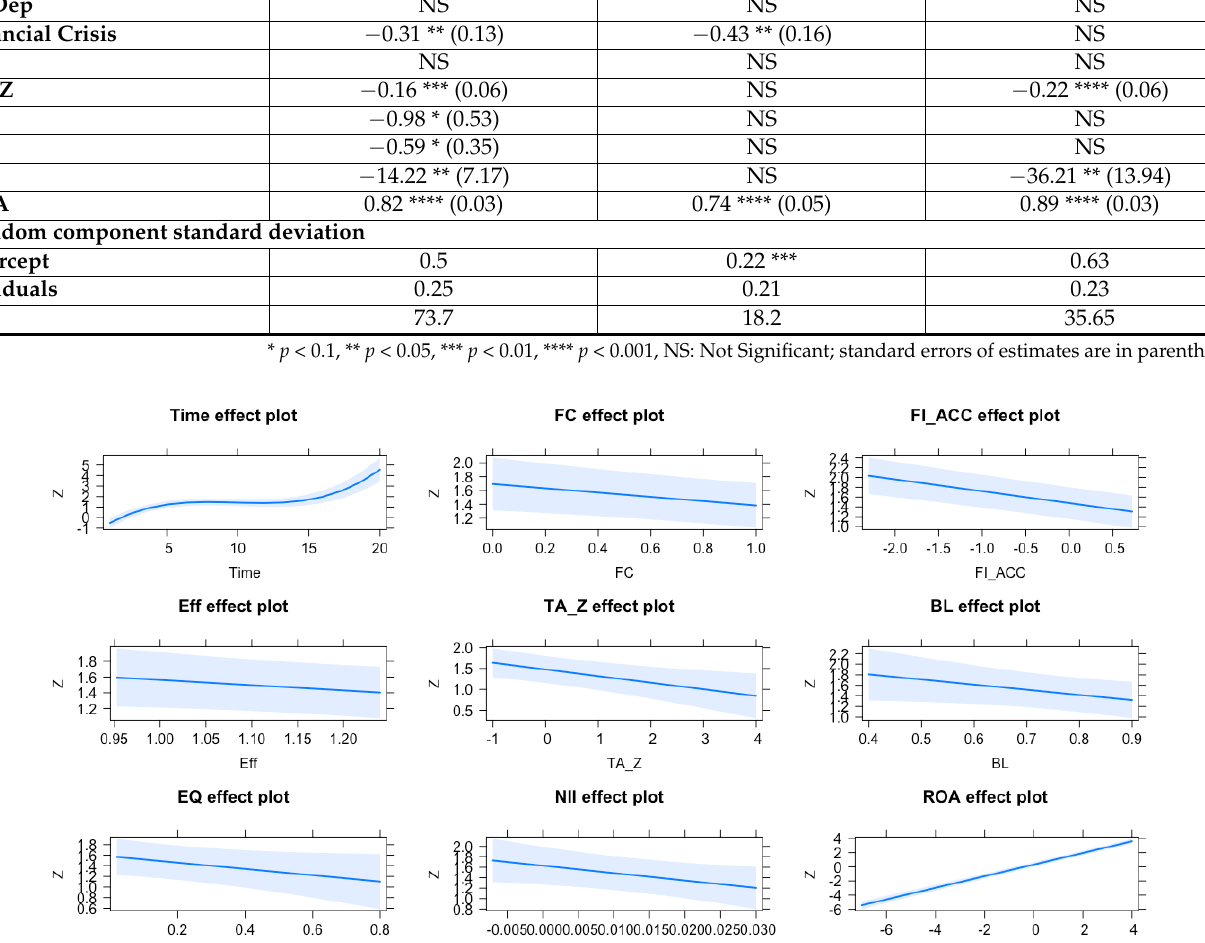
Figure 6. Significant factor effect plots for Islamic banks.